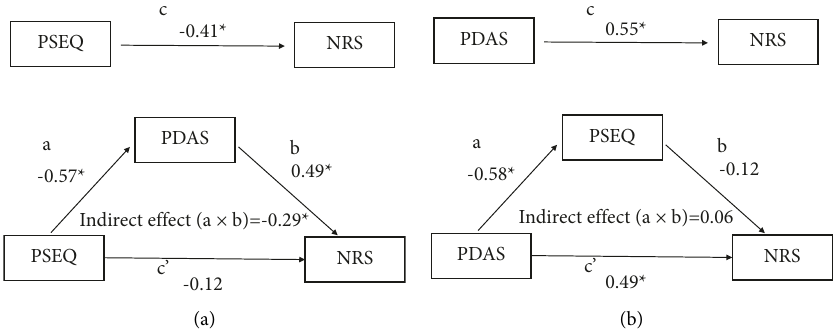
Figure 2: Mediating effect of changes in disability on the relationship between change in self-efficacy and change in pain in the exercise group. (a) The path c indicates the total effect of the whole model. The paths a and b indicate the mediating pathways of change in self- efficacy on change in disability and of change in disability on change in pain. The path c’ is the direct effect of change in self-efficacy on change in pain. (b) The paths a and b indicate the mediating pathways of change in disability on change in self-efficacy and of change in self- efficacy on change in pain. The path c’ is the direct effect of change in disability on change in pain. PSEQ, Pain Self-Efficacy Questionnaire; PDAS, Pain Disability Scale; NRS, Numerical Rating Scale of pain. ∗ P < 0 .